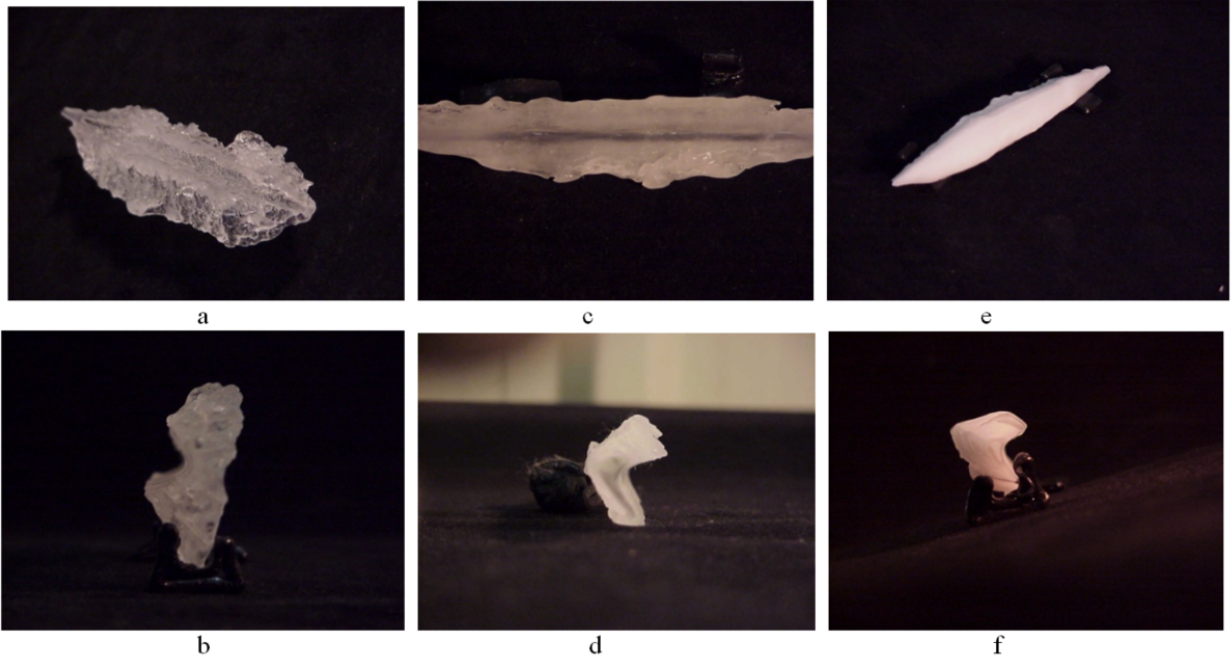
Figure 1. Pictures of ice, accreted on the leading edge of the wings and cross-sections, ( a , b ) glaze ice accreted at − 3 °C ( c , d ) mixed phase ice accreted at − 7 °C to − 13 °C ( e , f ), rime ice accreted at − 20 °C and below.